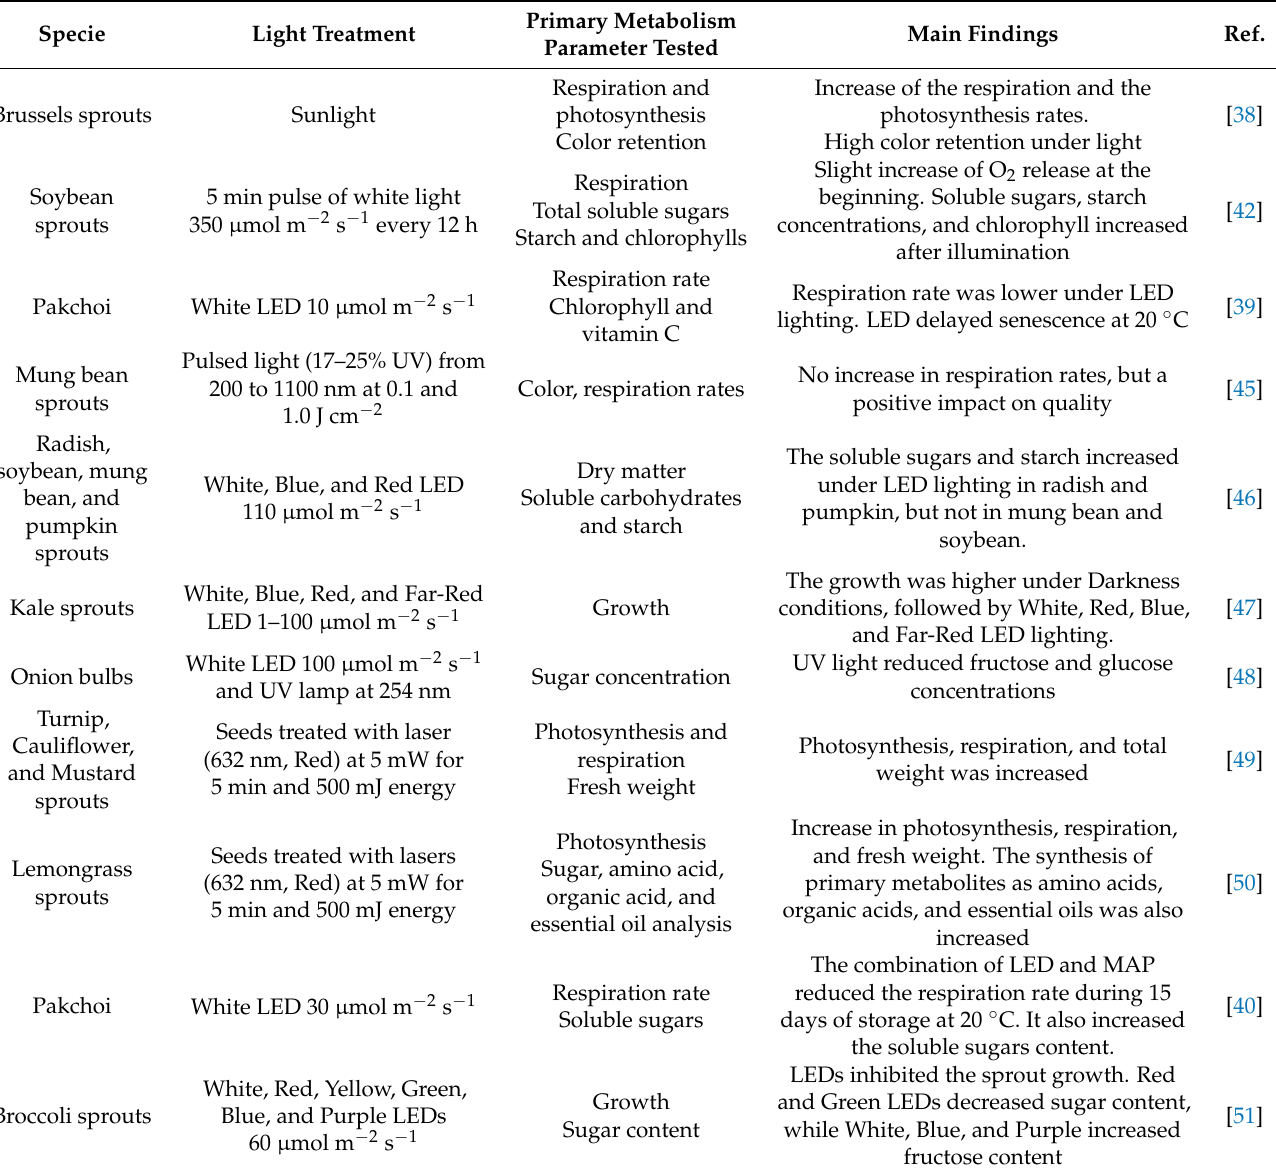
Table 2. State-of-art of main effects regarding sprout primary metabolism under different illumination wavelengths from the visible